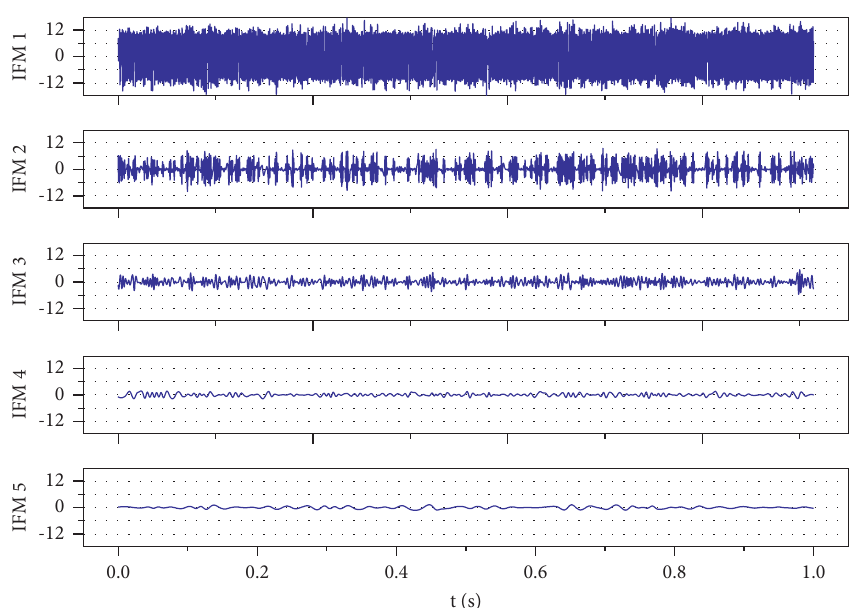
Figure 6: IMFs decomposed from building vibration signals using